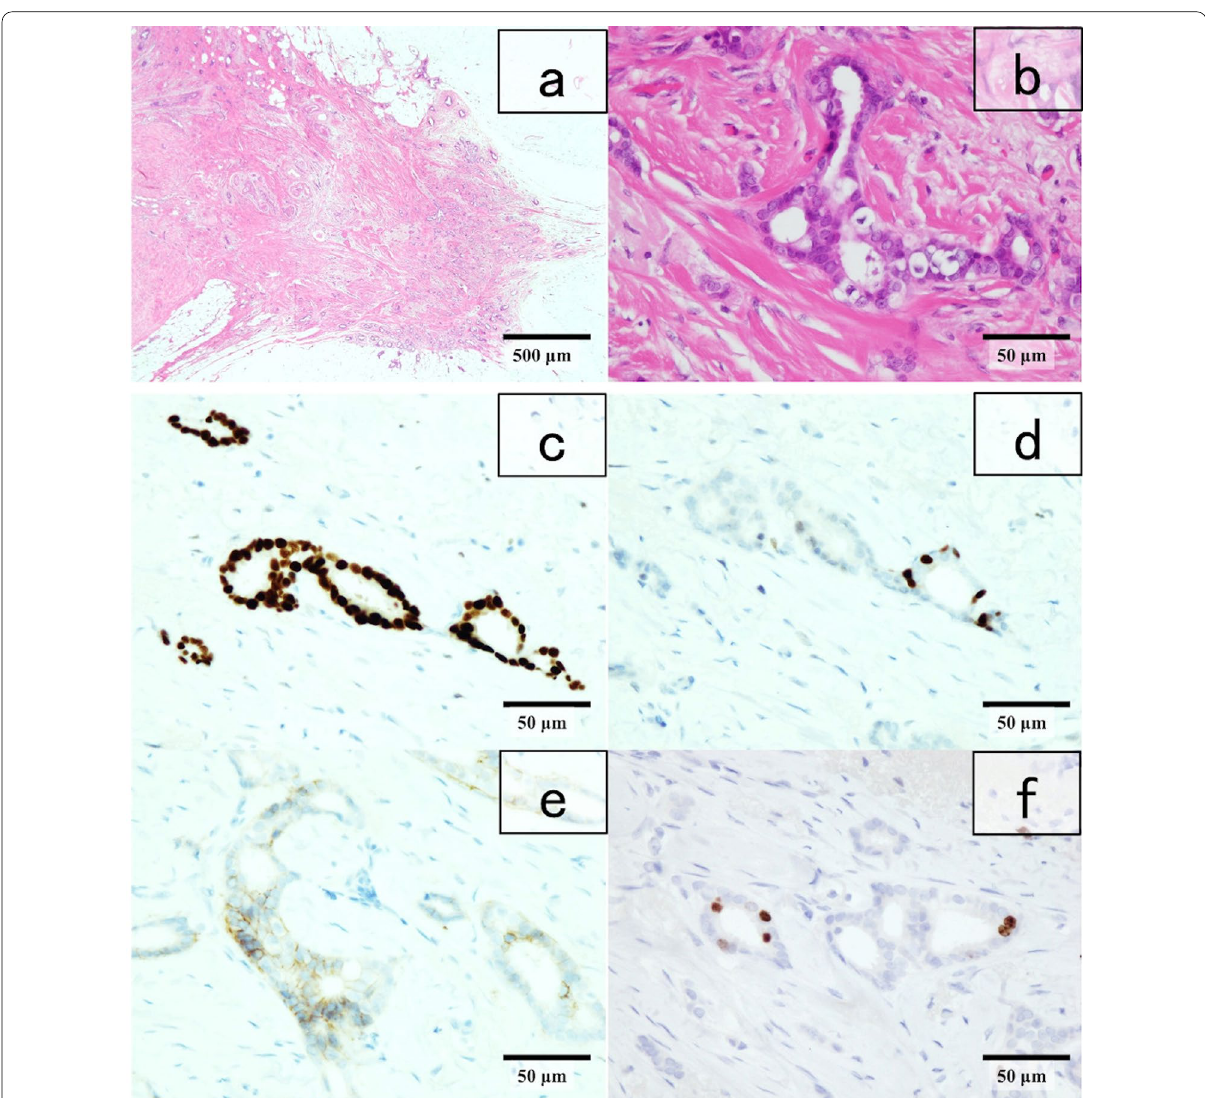
Fig. 5 Postoperative histopathological findings of breast tumor. a , b Invasive ductal carcinoma, tubule forming type, nuclear grade 1, histological grade I (hematoxylin–eosin stain; magnification, breast ( 400), and HER2 amplification is absent in FISH. ER estrogen receptor, FISH fluorescent in situ hybridization, HER2 human epidermal growth × factor receptor-2, PR progesterone